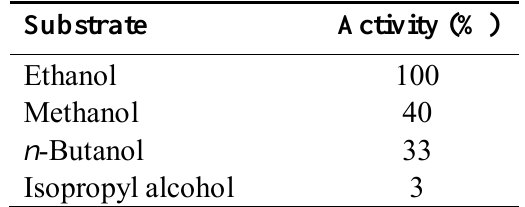
Table 2 . Substrate selectivity of the